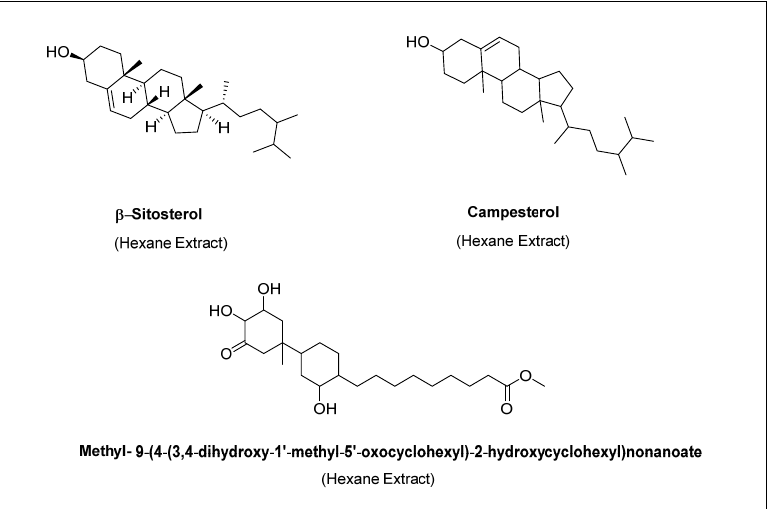
Figure 3. The major secondary metabolites identified in the hexane extracts of Anastatica hierochuntica .